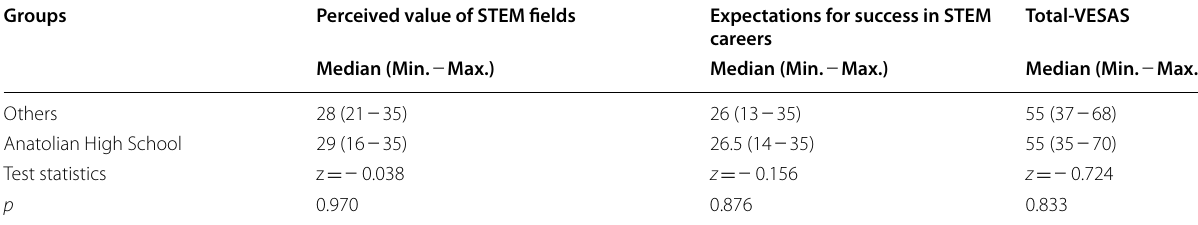
Table 3 Mann Whitney U test results for participants’ STEM motivation scores according to high school type graduated Groups Perceived value of STEM fields